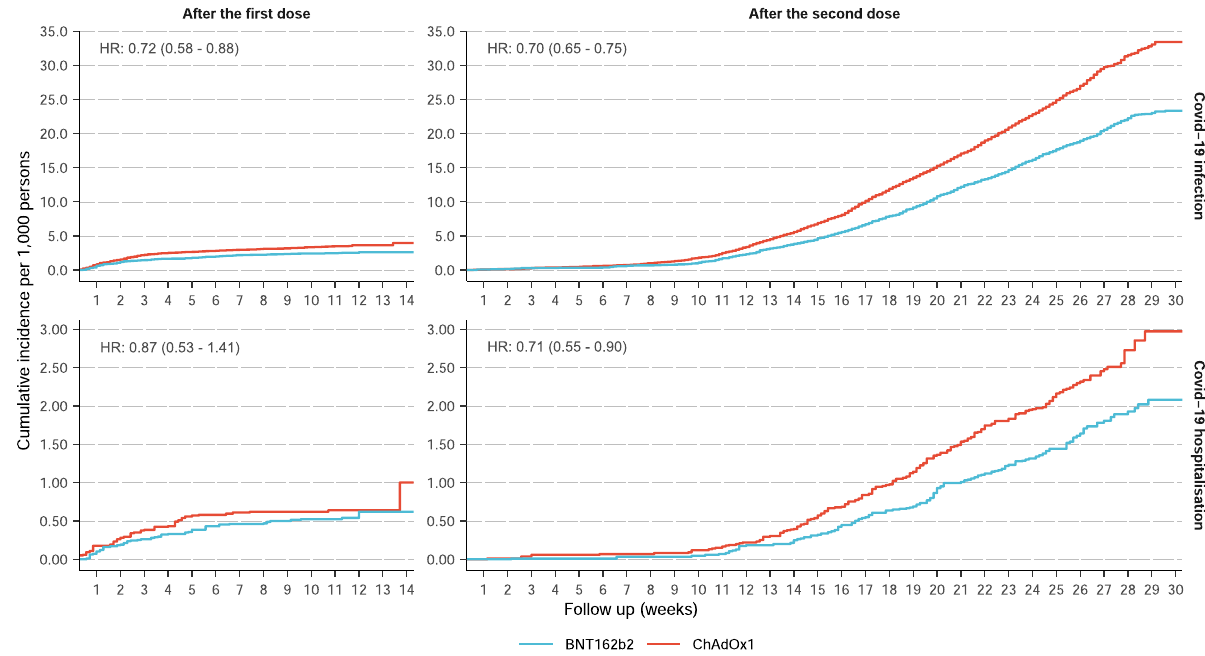
Fig. 3 Kaplan-Meier cumulative incidence curves of Covid-19 infection and hospitalisation after one and two doses of vaccines. The different Y-axis scales for Covid-19 infection and hospitalisation outcomes. The follow-up was up to 14 weeks after the fi rst dose and 30 weeks after the second dose of the vaccine. HR hazard